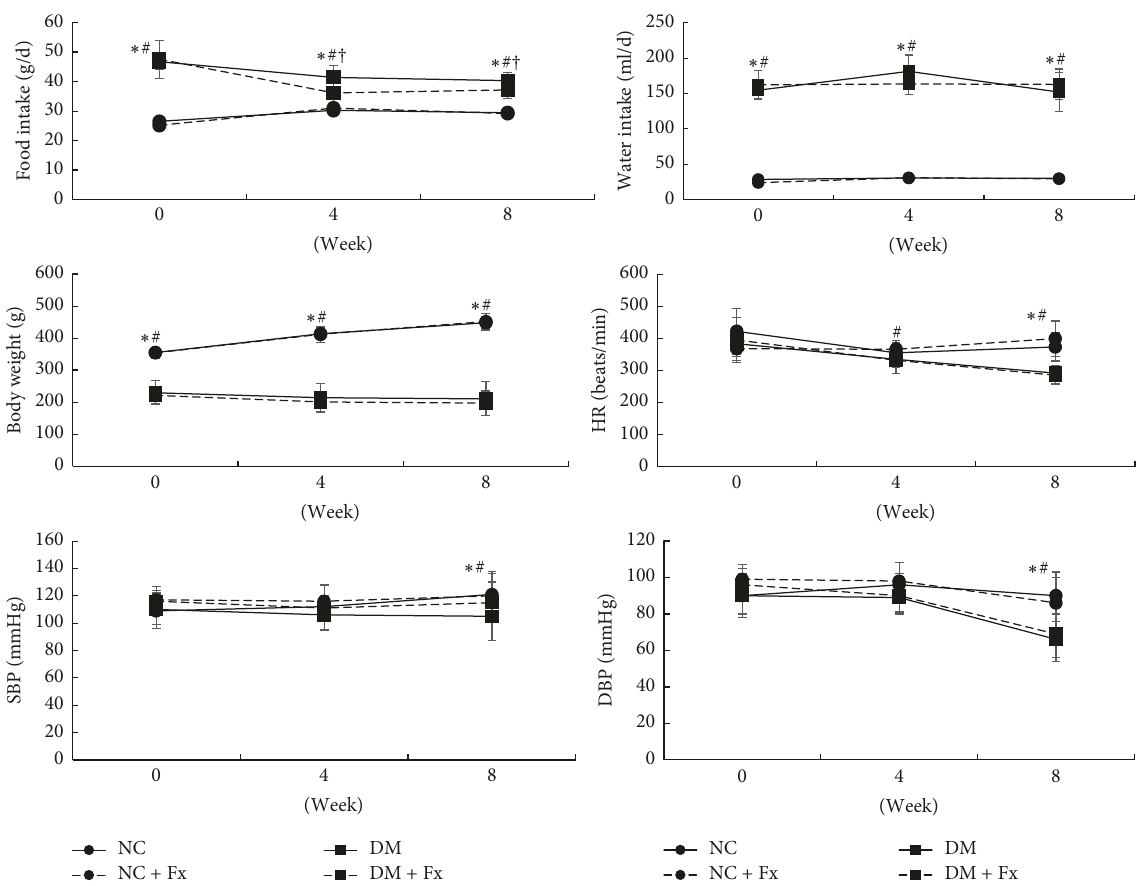
Figure 2: Time course of food intake, water intake, body weight, and main vital signs during the experiment after induction of diabetes. Heart rate (HR), systolic blood pressure (SBP), and diastolic blood pressure (DBP) were recorded by an indirect tail-cuff method. The circle with solid and dashed lines represents NC and NC + Fx groups, respectively, while the block symbol with solid and dashed lines shows data of DM and DM + Fx groups, respectively. Data are expressed as mean ± SD. Statistical significance ( 푃 < 0.05 ) was labeled as ∗ , #, and † correspondingly, when the DM + Fx group was compared with NC, NC + Fx, and DM groups.